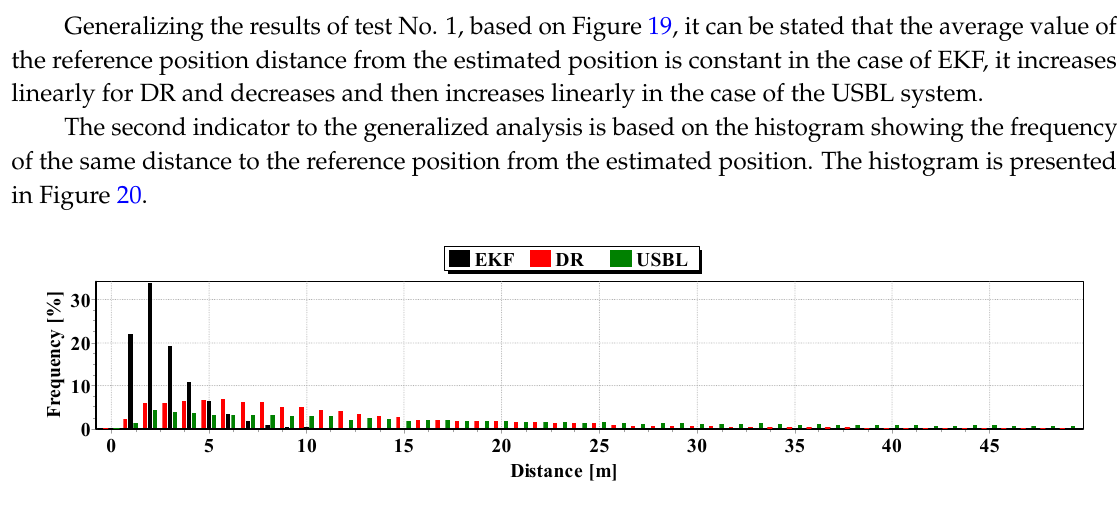
Figure 20. Histogram of the reference position distance from the position estimated by EKF and DR methods and determined by the USBL system (one hundred passages).